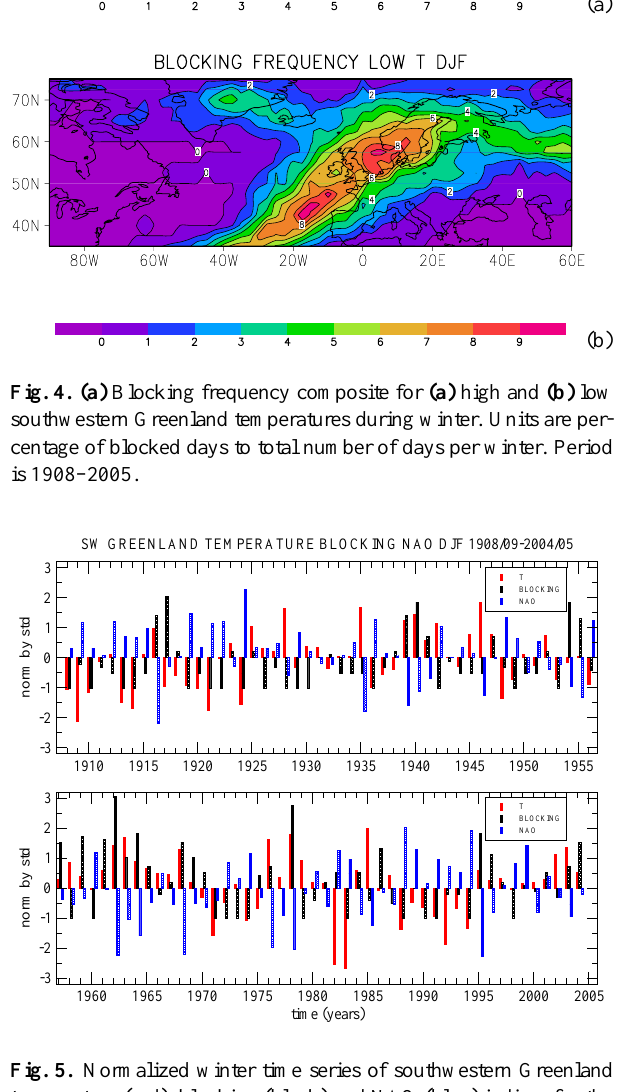
Fig. 5. Normalized winter time series of southwestern Greenland temperature (red), blocking (black) and NAO (blue) indices for the period